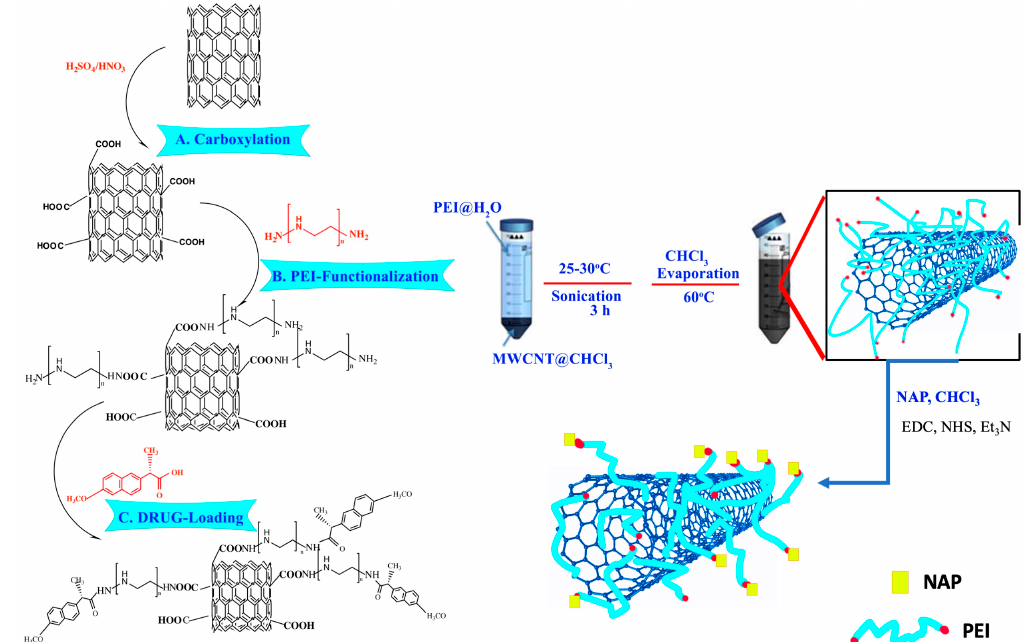
Figure 1. General synthetic